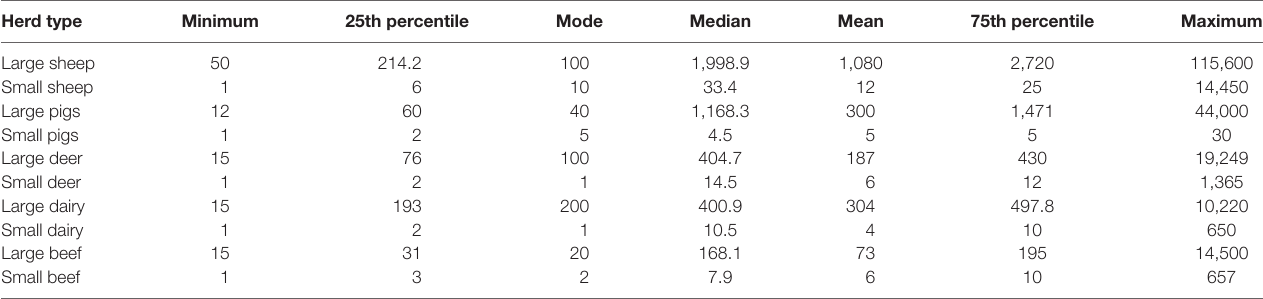
Table 2 | Descriptive data for each of the herd types used to parameterize Australian Animal Disease. herd type Minimum